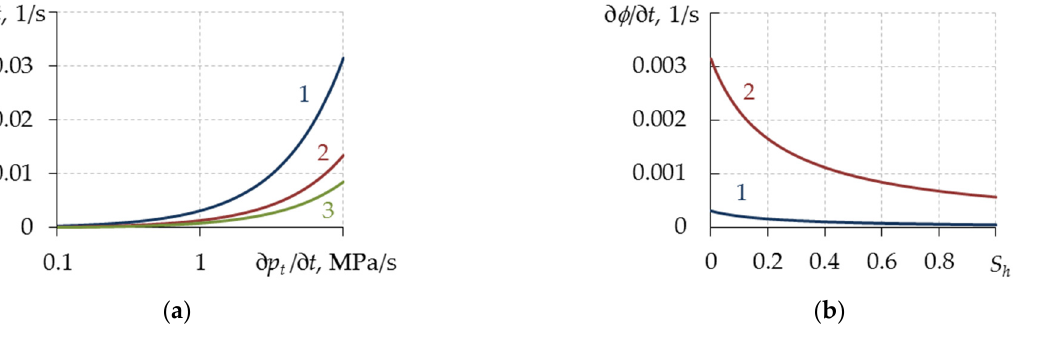
Figure 3. Change in porosity with time depending on the changes in total pore pressure ( a ) and hydrate saturation ( b ). ( a ) Lines 1, 2 and 3 correspond to S h = 0, 0.3 and 0.6. ( b ) Lines 1 and 2 correspond to ∂ p t / ∂ t = 0.1 and 1 MPa/s.